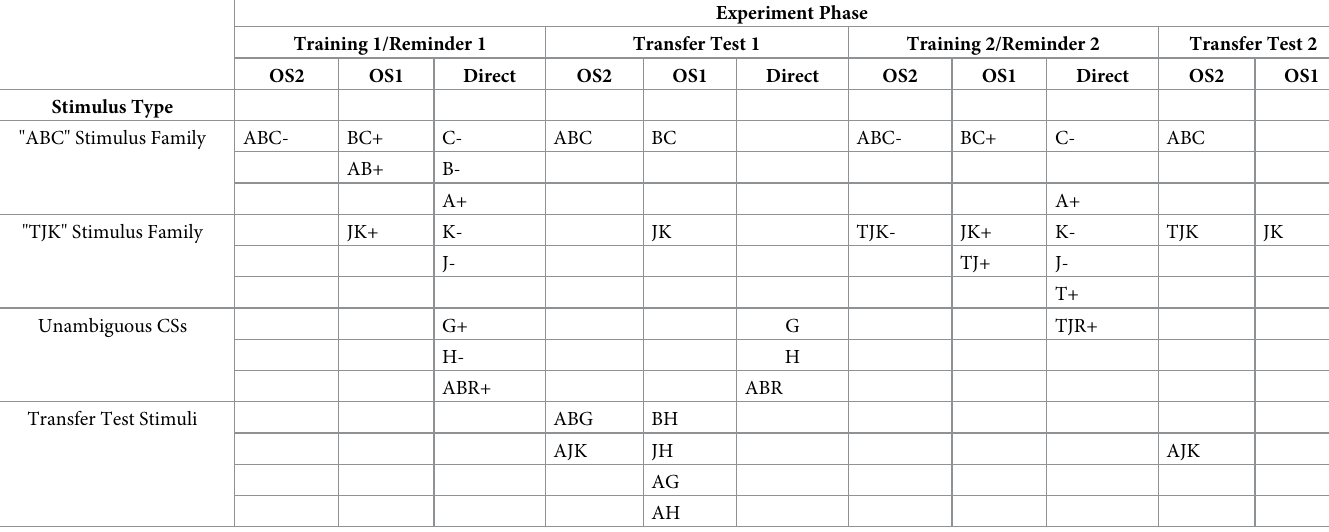
Table 1. Summary of Experiment 1 Design. When three stimuli are listed (e.g., ABC-), 2nd-order occasion setting is hypothesized to be learned (except for ABR+ and TJR+). When two stimuli are listed (e.g., BC+), 1st-order occasion setting is hypothesized to be learned. When one stimulus is presented (e.g., C-), direct associative learn- ing is hypothesized to be learned. All stimuli within a trial were presented serially. "+" indicates reinforcement; "-" indicates no reinforcement; "OS2" indicates 2nd-order occasion setting; "OS1" indicates 1st-order occasion setting; "Direct" indicates direct associative learning. Notably, the "ABC" family was trained in 2nd-order occasion set- ting before Transfer Test 1 and 2; the "TJK" family was only trained in 1st-order occasion setting before Transfer Test 1 but was trained in 2nd-order occasion setting before Transfer Test 2. This allowed the examination of whether "A" was indeed a 2nd-order occasion setter by testing "A" with "JK" before and after "JK" was trained with 2nd- order occasion setter "T." We predicted "A" would affect "JK" more strongly after "JK" was trained with "T" than before that training.